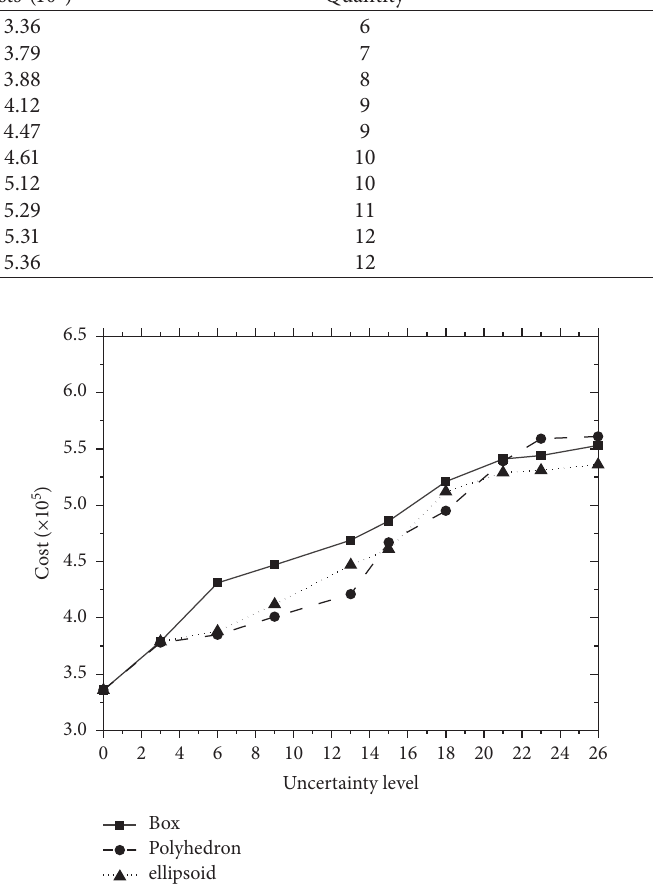
Figure 5: Impact of uncertainty level on total